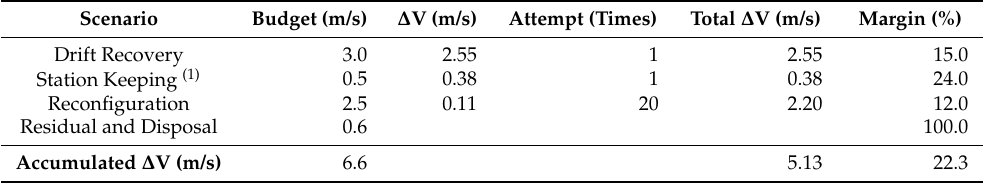
Table 8. Propellant budget for each orbit maneuver scenario.